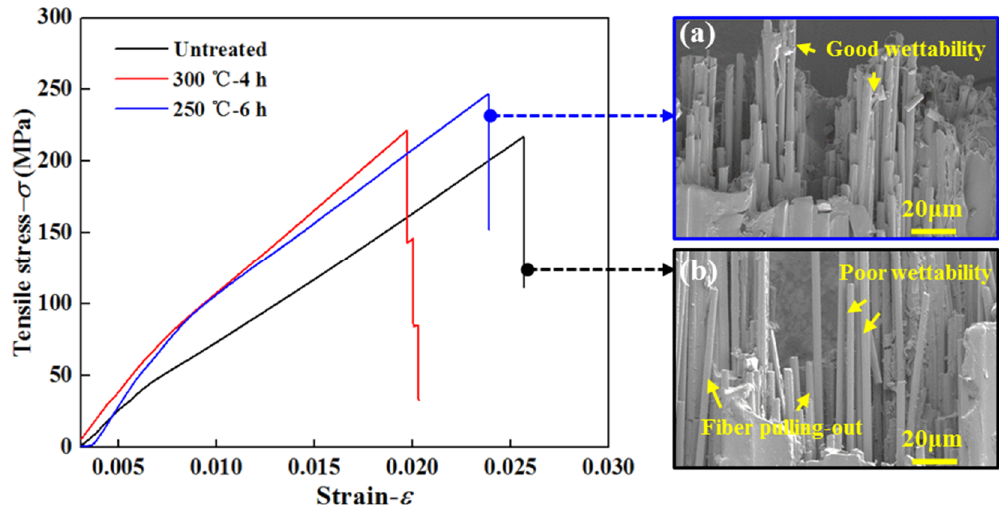
Figure 12. Effect of heat treatment processes on tensile properties of FDM 3D-printed continuous-fiber-reinforced PEEK composites: ( a ) 250 °C-6 h; ( b ) Untreated sample.